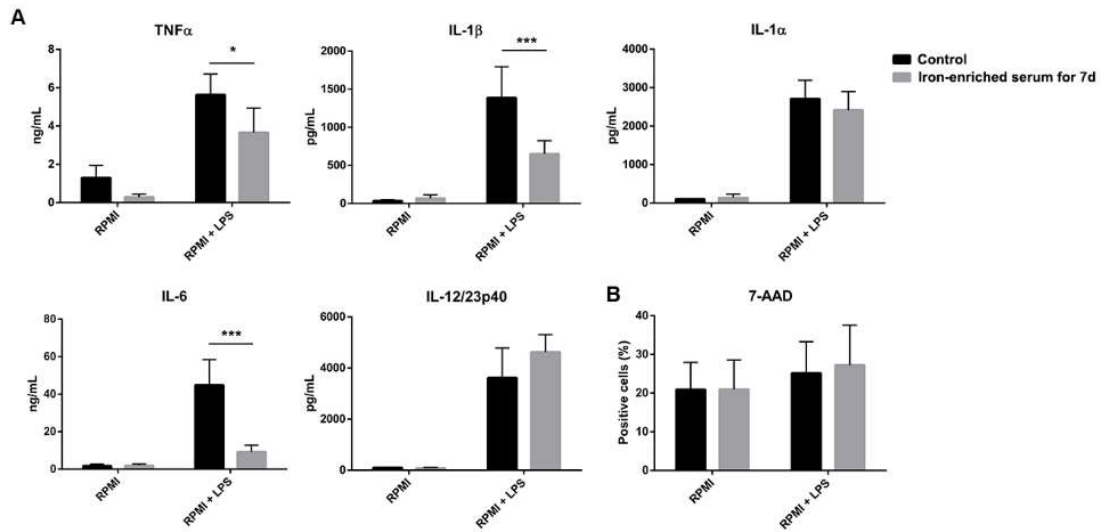
Figure 2. Iron added to differentiating BMDCs (Bone-marrow derived dendritic cells) blocks their differentiation, decreasing the secretion of TNFα, IL-6 (Interleukin) and IL-1β after 24 h of LPS stimulation ( A ). 7-AAD (7-Aminoactinomycin D) staining shows that cells are alive when grown in iron-enriched medium ( B ). * p < 0.05 *** p < 0.001 .